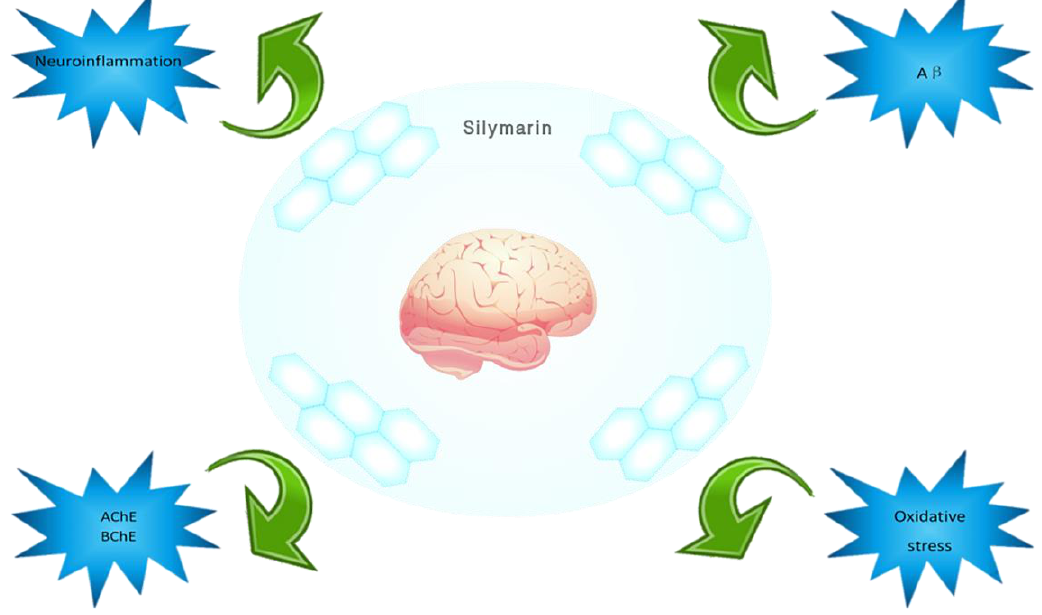
Figure 7. Silymarin’s inhibition and treatment e ff ects for Alzheimer’s disease.